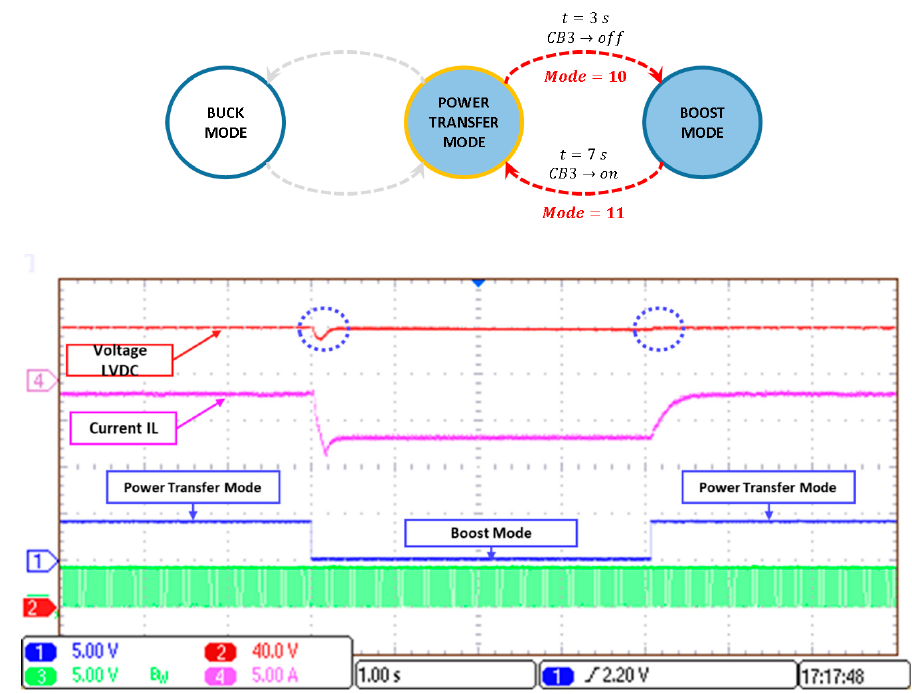
Figure 22. Experimental waveforms to transition between power transfer and boost modes.